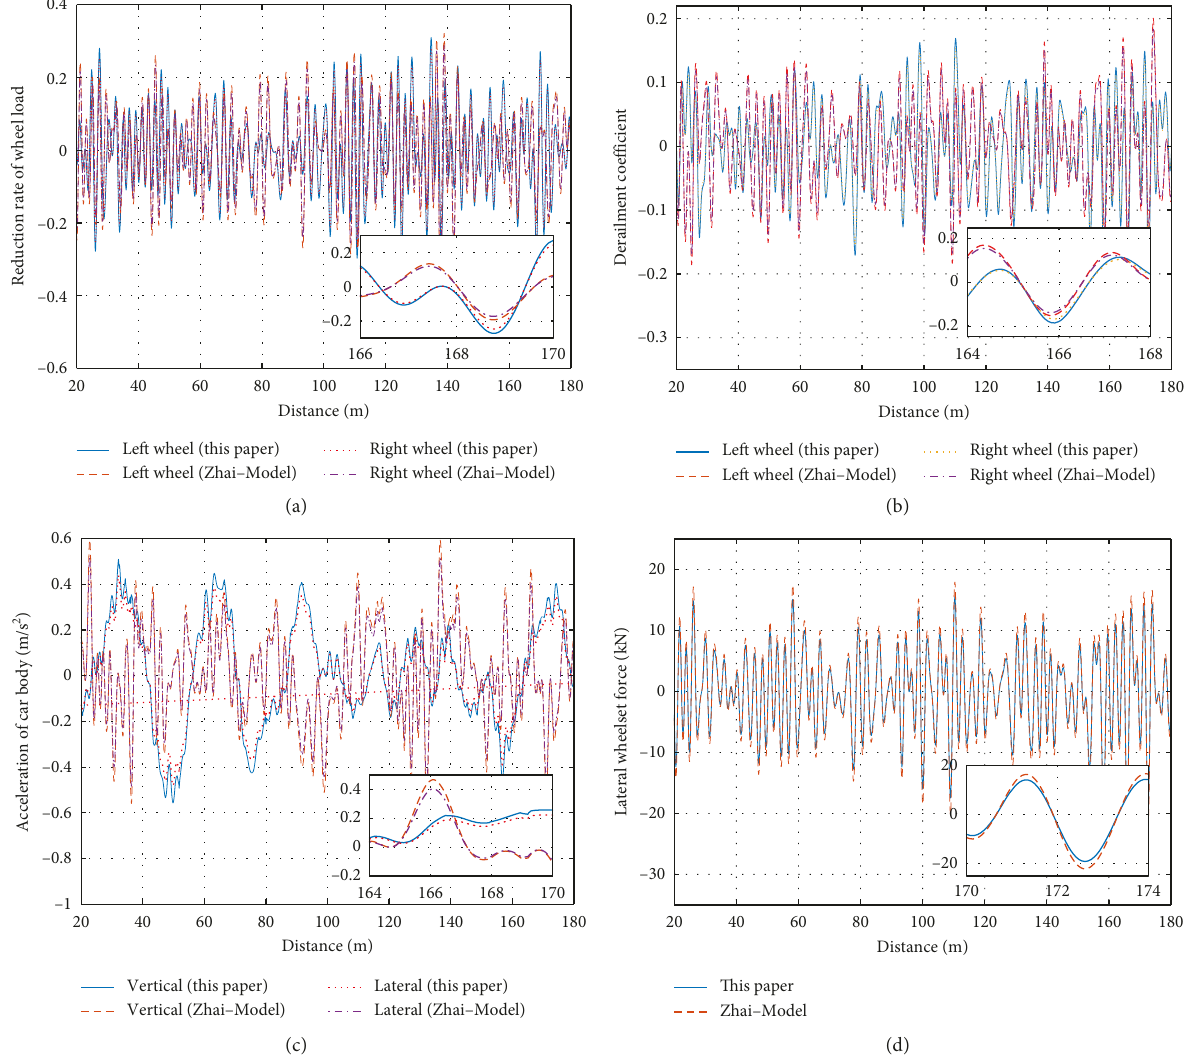
Figure 11: Comparison of calculation results for a single sample. (a) Reduction rate of wheel load, (b) derailment coefficient of wheel load, (c) acceleration of car body, and (d) lateral wheelset